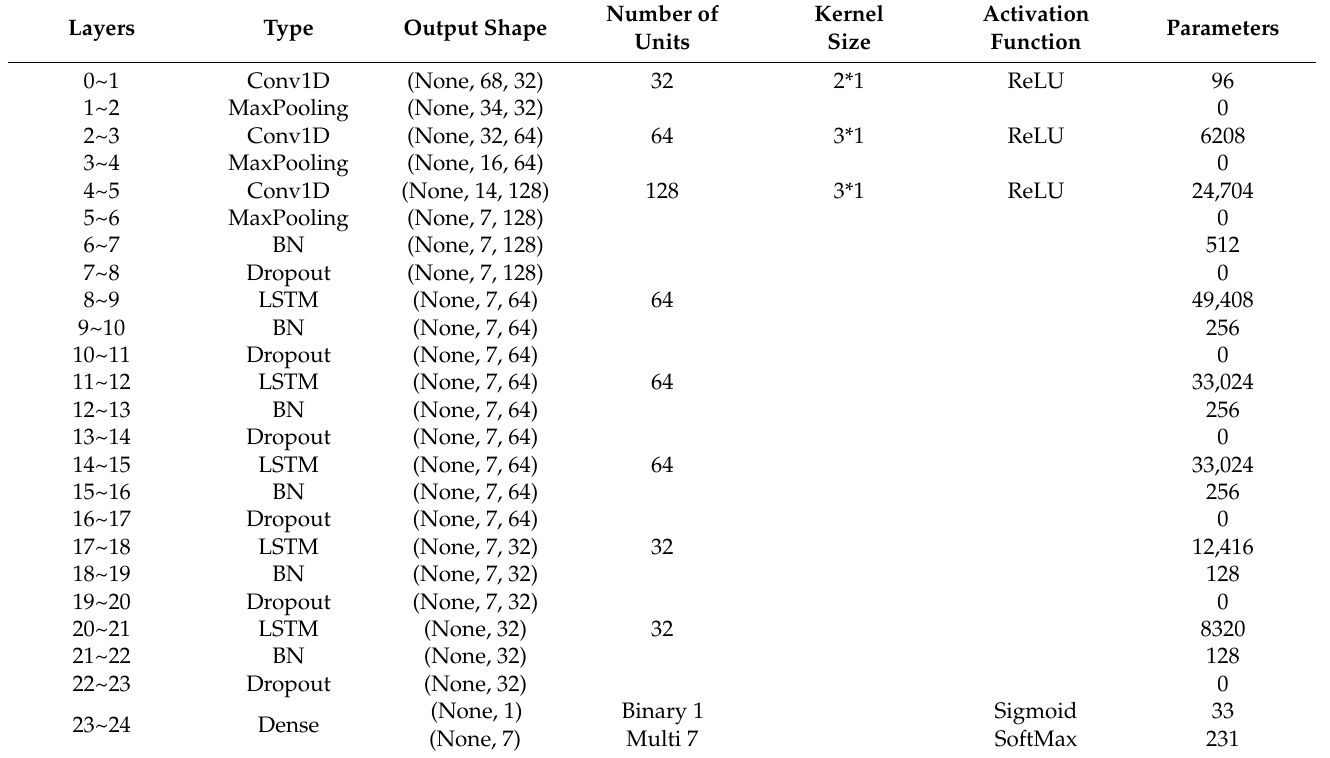
Table 17. CNN + LSTM-8-256 (8 layers and 256